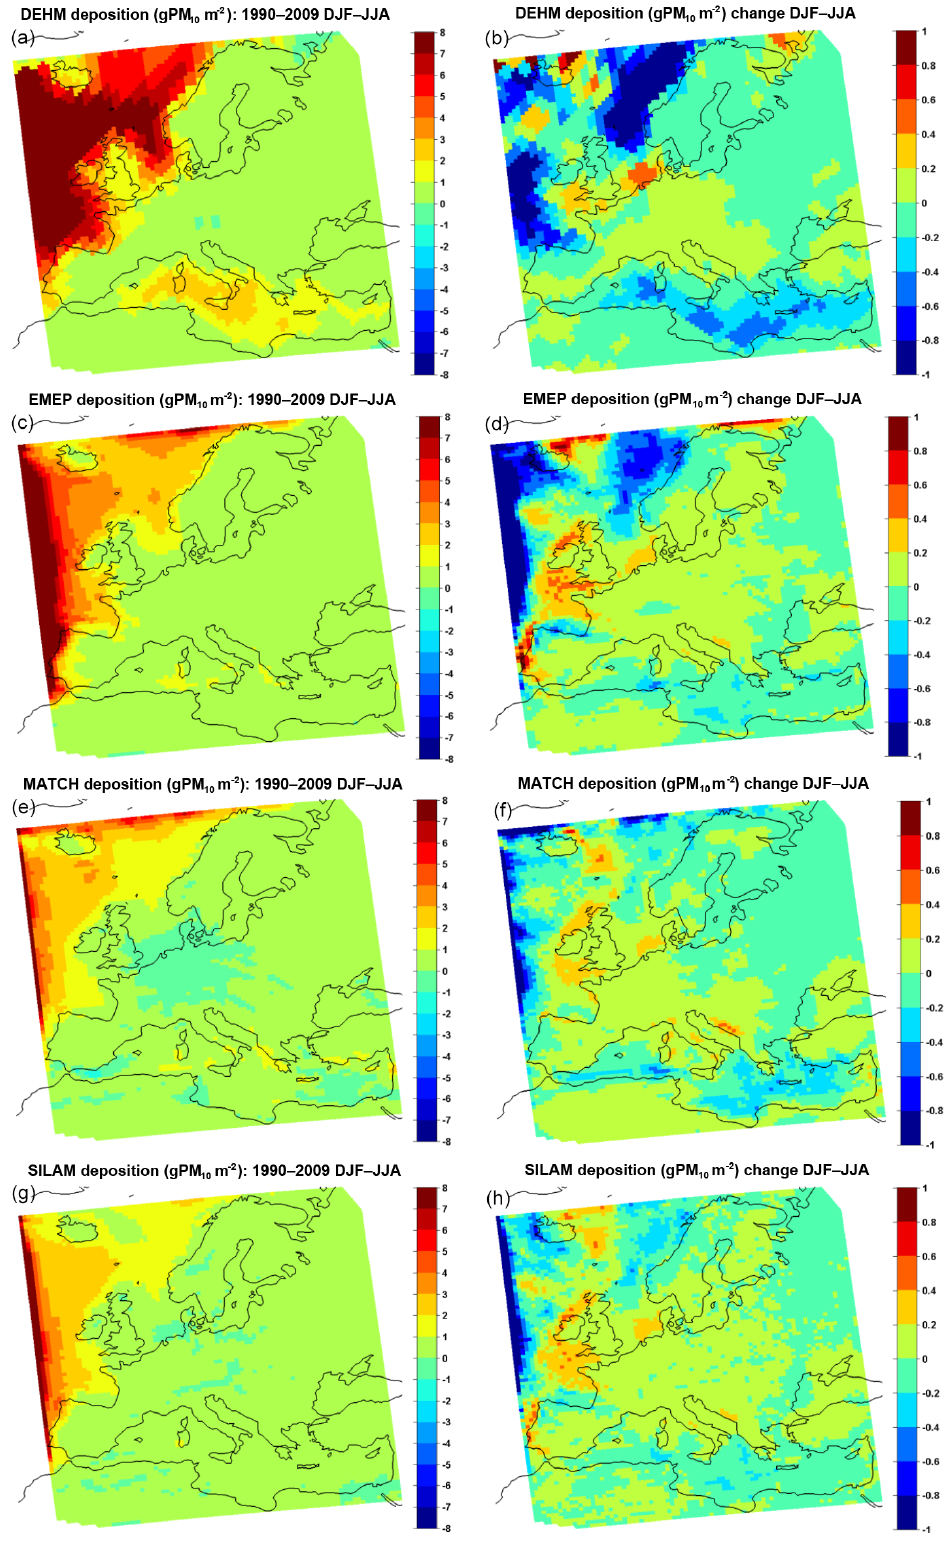
Figure 8. Sea salt annual deposition (gPM 10 m − 2 ) difference between winter (December, January, and February: DJF) and summer (June, July, and August: JJA) for DEHM, MATCH, and SILAM models. Left panels: past period (1990–2009); right panels: absolute difference between future (2040–2059) and past